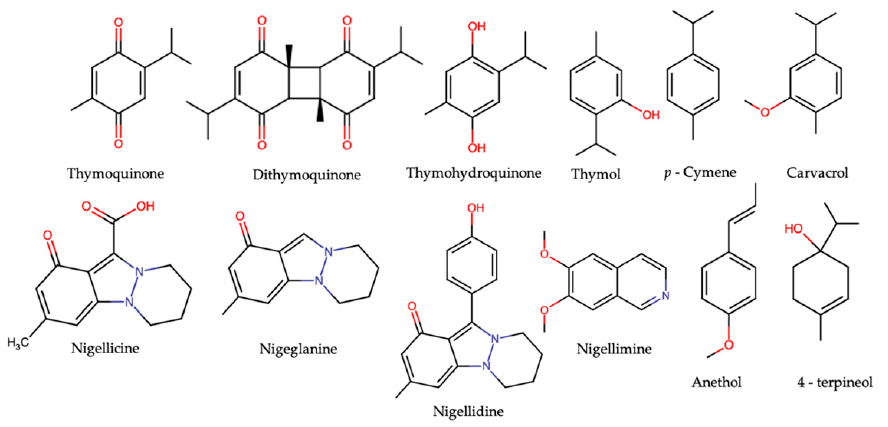
Figure 2. Some main components of N. sativa .